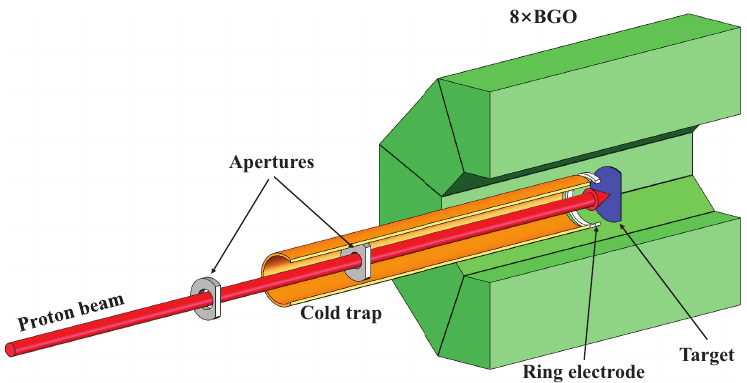
Figure 1: Schematic of the experimental